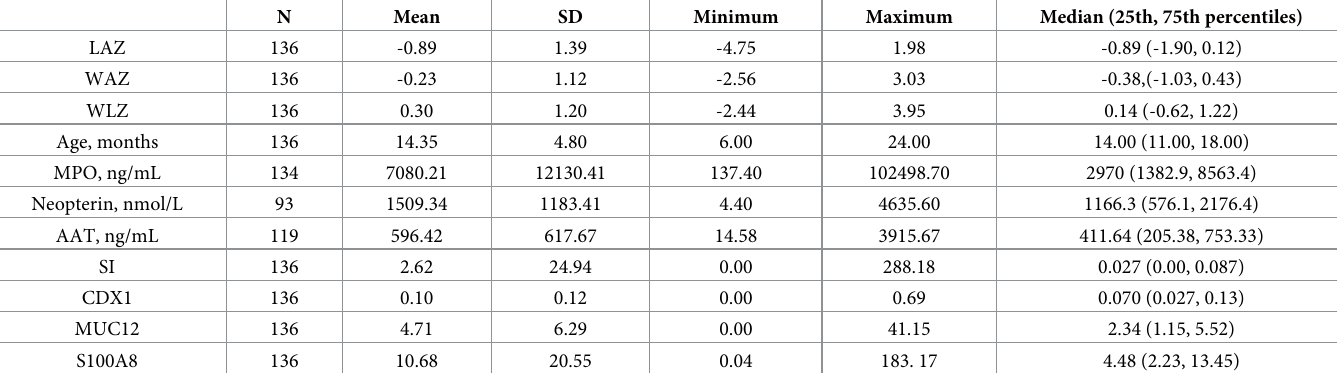
Table 1. Demographic characteristics and descriptive statistics of infants and